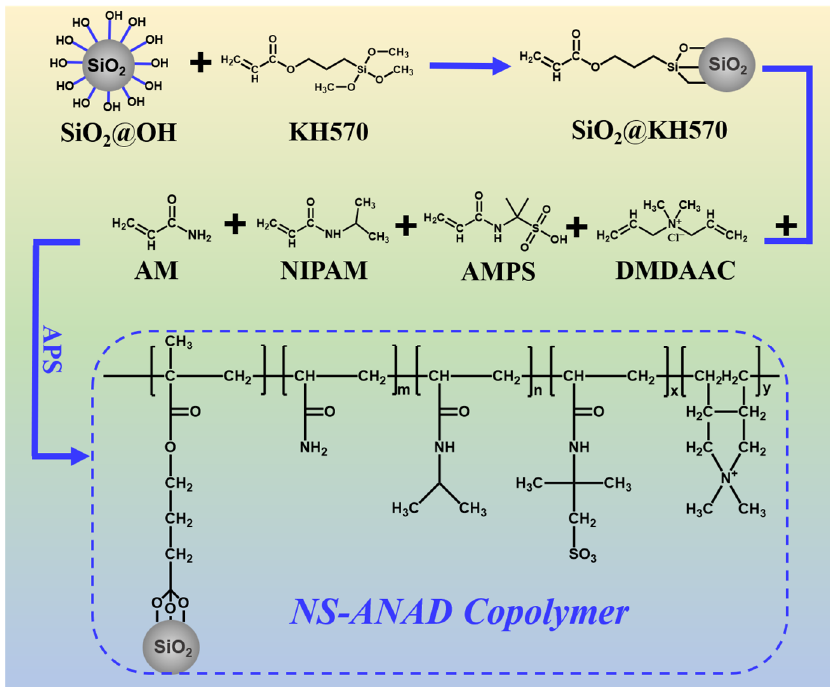
Figure 1. The synthesis procedure and structural formula of NS-ANAD